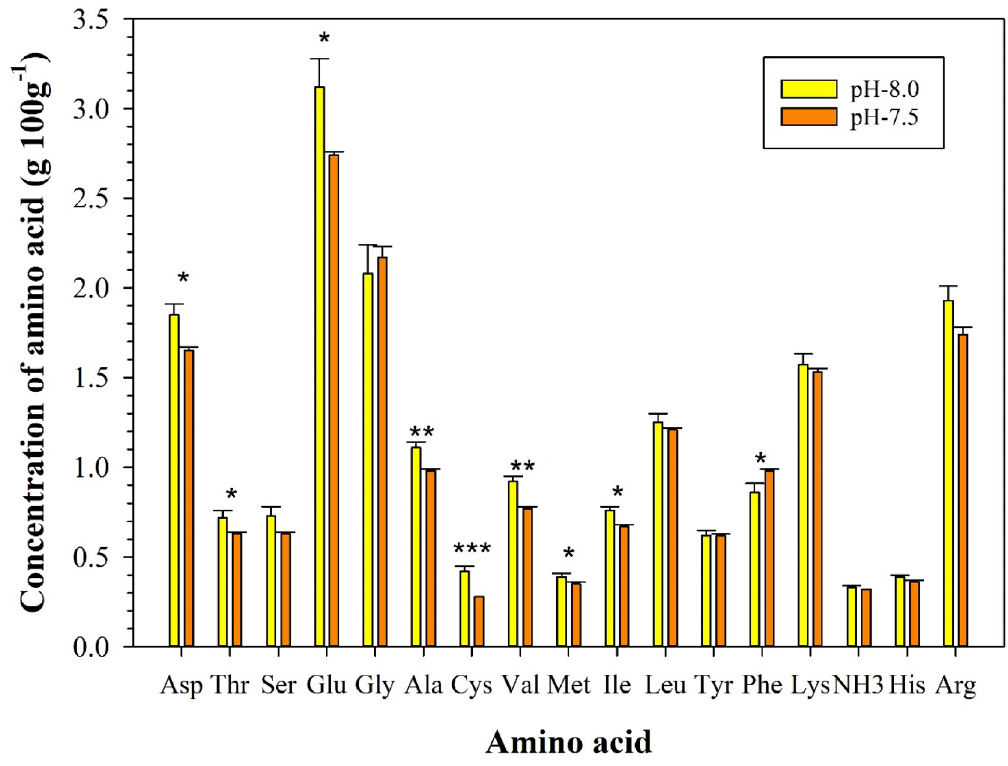
Figure 3. Concentrations of amino acids in the muscle of tiger shrimp at two different pH treatments (8.0 and 7.5). Values are means ± S.E (n = 6). Asterisk: statistically significant (* p < 0.05, ** p < 0.01, *** p < 0.001). Asp (Aspartic acid), Thr (Threonine), Ser (Serine), Glu (Glutamic acid), Gly (Glycine), Ala (Alanine), Cys (Cysteine), Val (Valine), Met (Methionine), Ile (Isoleucine), Leu (Leucine), Tyr (Tyrosine), Phe (Phenylalanine), Lys (Lysine), His (Histidine), Arg (Arginine).